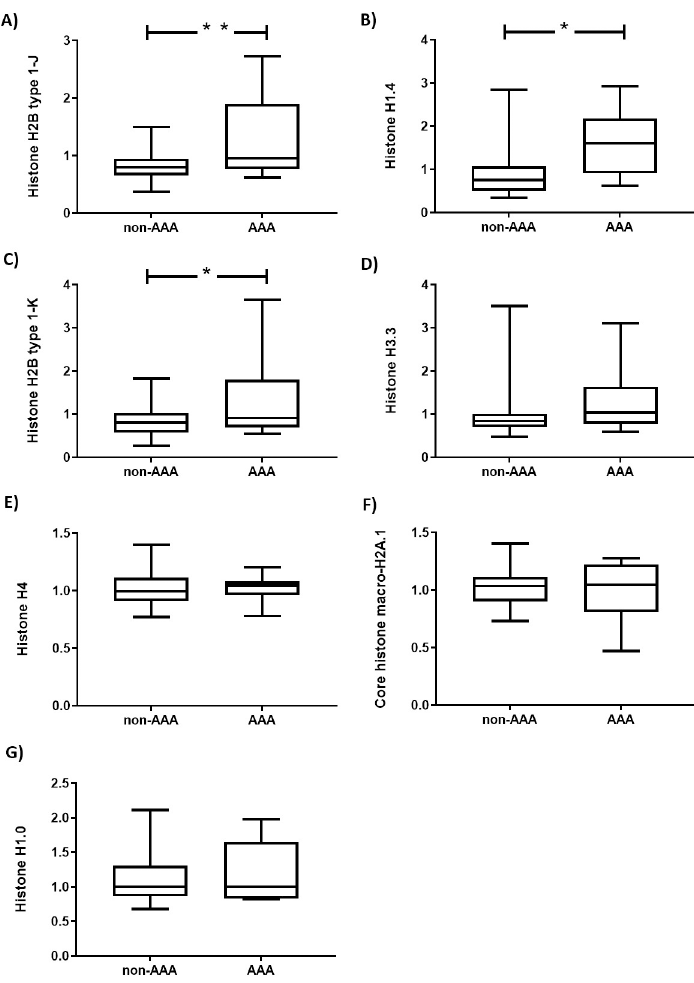
Fig 1. The relative amount of histones in patients with and without AAA. Histone H2B type 1-J(A), histone H1.4 (B), histone H2B type 1-K (C), histone H3.3 (D), histone H4 (E), core histone macro-H2A.1 (F) and histone H1.0 (G). Data are presented as median, interquartile and range. (cid:3)(cid:3) indicates p < 0.001, (cid:3) indicates p < 0.01 (without correction for multiple testing).